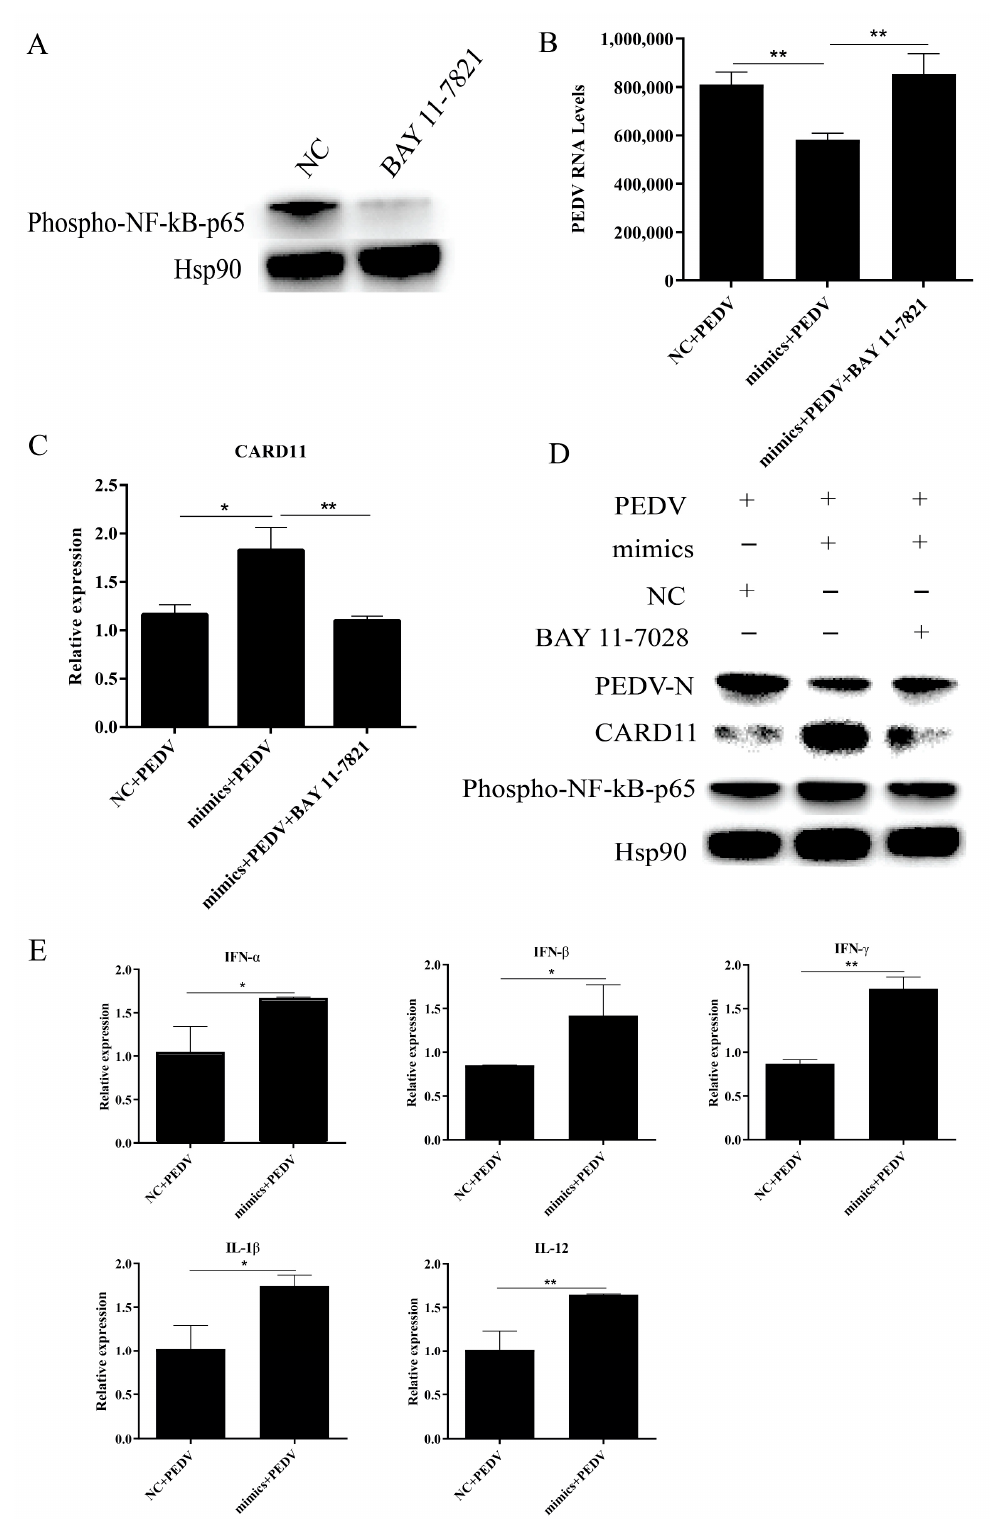
Figure 5. miR-129a-3p activates EDA -mediated NF- κ B pathway. ( A ) WB results after BAY 11-7028 treatment. ( B ) Changes of PEDV M gene expression in different treatment groups. ( C ) Changes of CARD11 gene expression in different treatment groups. ( D ) WB results of PEDV-N, CARD11, and Pp65 proteins in different treatment groups. ( E ) Changes of 1L-12 , IL-1 β , IFN- α , IFN- β , and IFN- γ gene expression in different treatment groups. The * denotes a significant difference with p < 0.05, while the ** denotes a significant difference with p < 0.01.